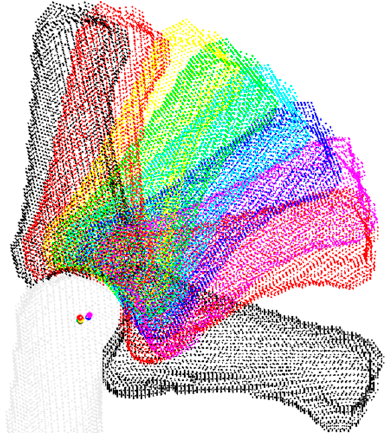
Figure 10. Estimated finite finger joint centers of rotation among different postures by the proposed method for the proximal interphalangeal joint of the index finger.